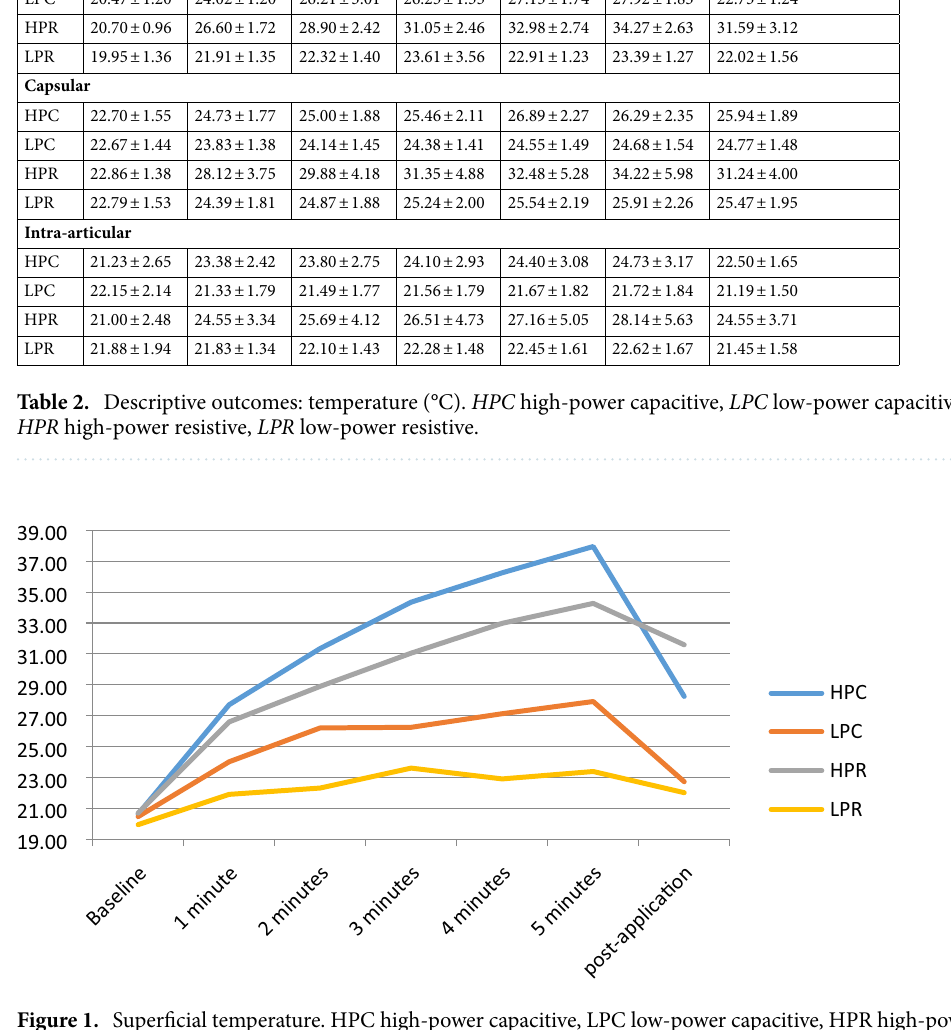
Figure 1. Superficial temperature. HPC high-power capacitive, LPC low-power capacitive, HPR high-power resistive, LPR low-power